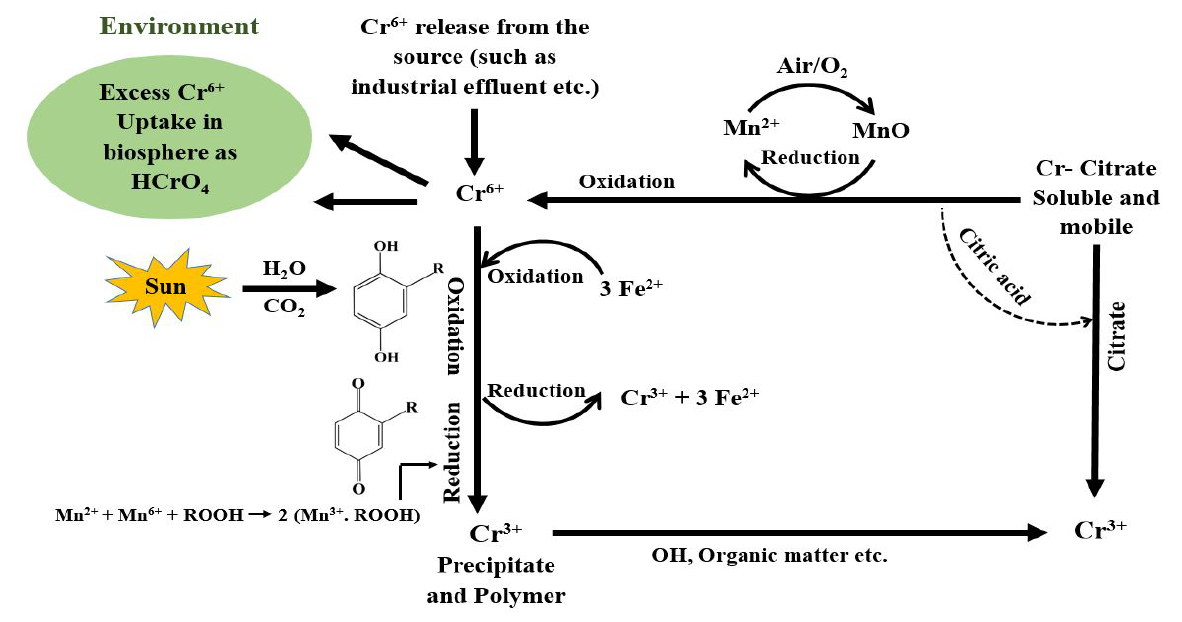
Figure 1. Chromium cycle in the environment.